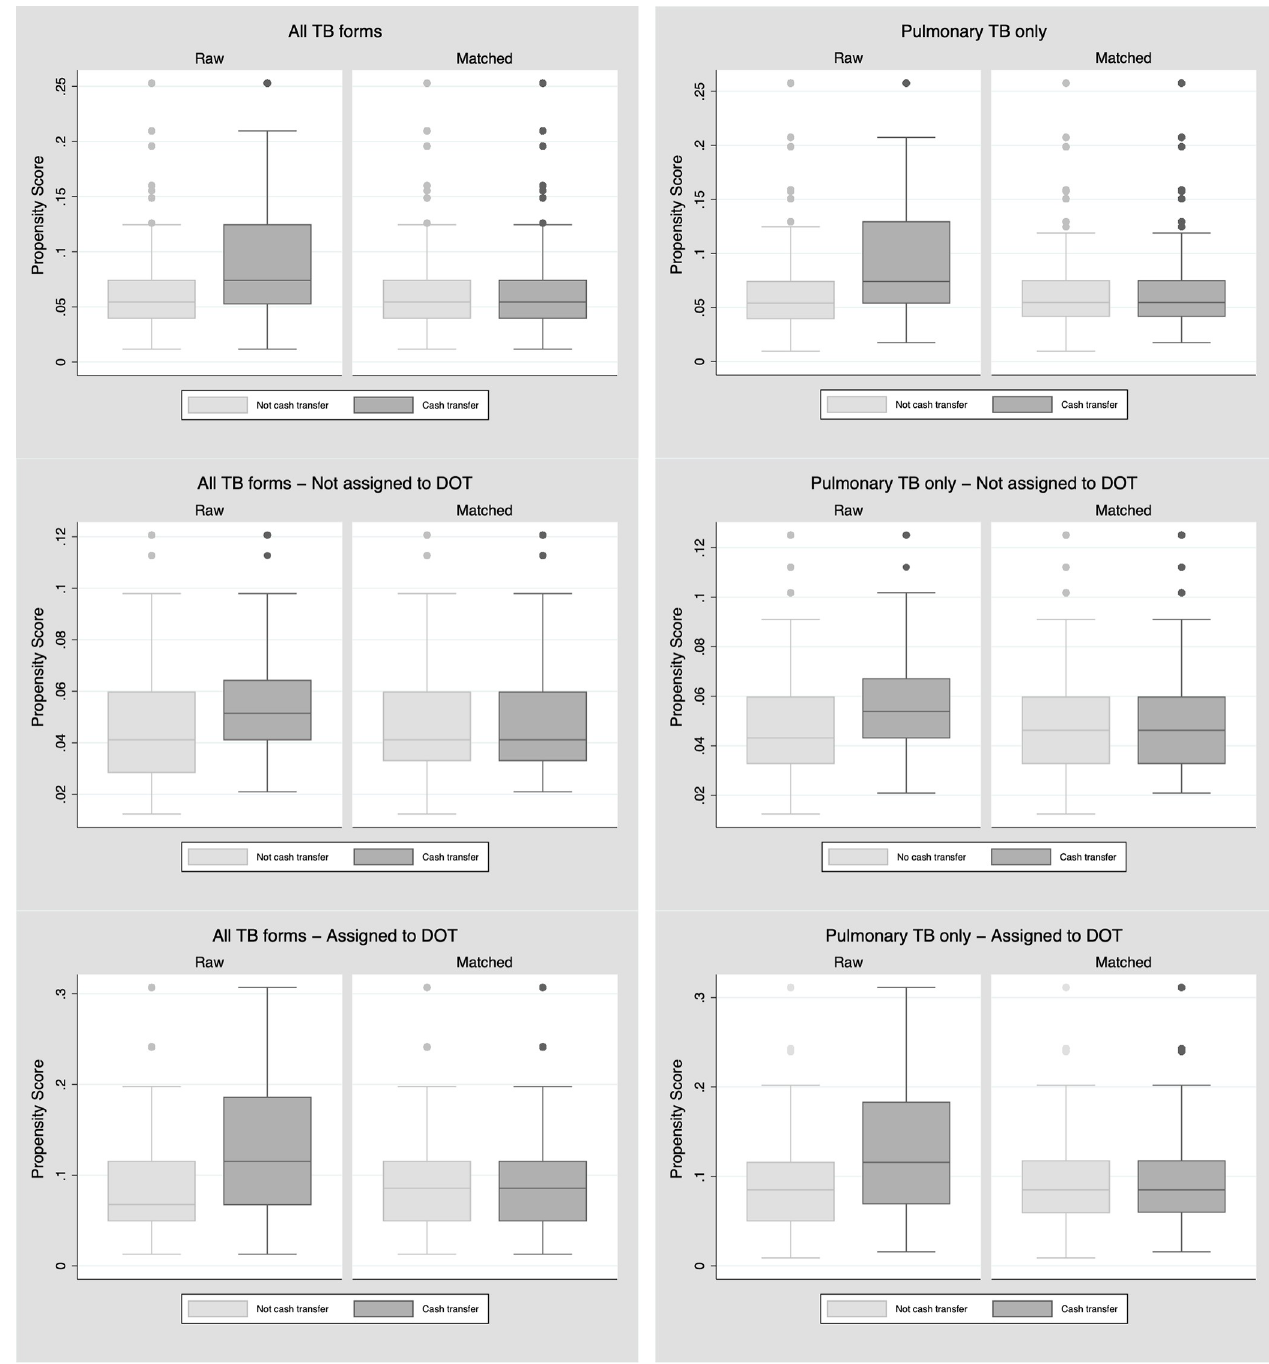
Fig 2. Balance box from propensity score matching of people from the Brazilian Notifiable Disease Information System database (SINAN-2015).